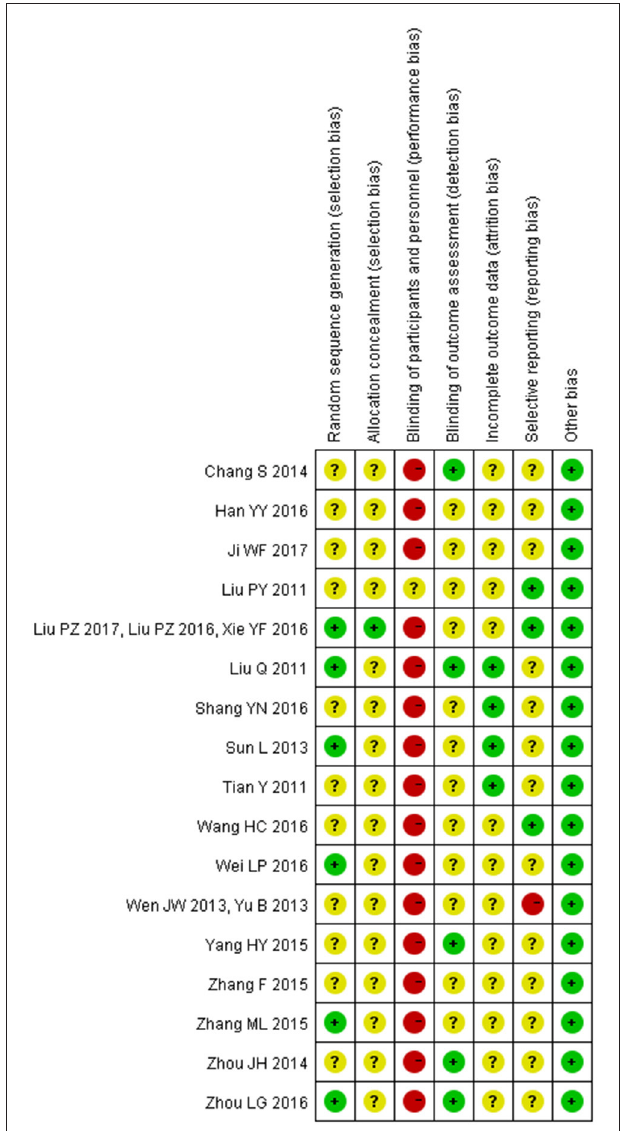
FIGURE 3 | Risk of bias summary: review authors’ judgements about each risk of bias item for each included